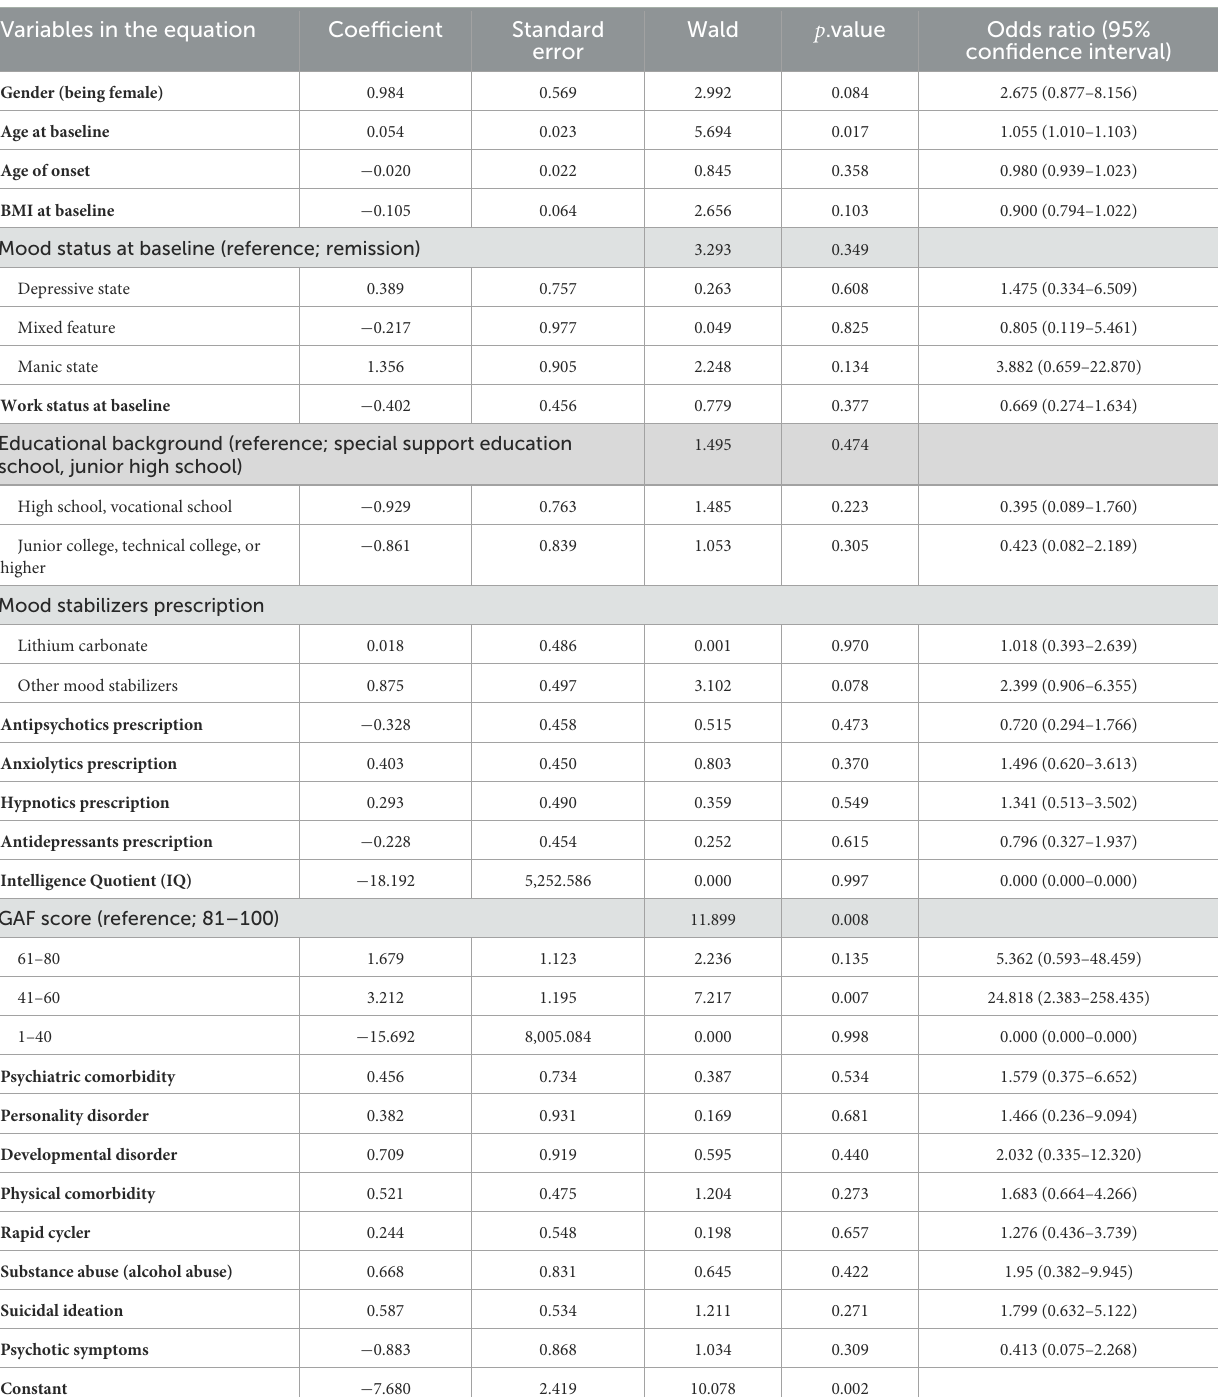
TABLE 5 Binomial logistic regression analysis of factors for psychiatric hospitalization among patients with bipolar II